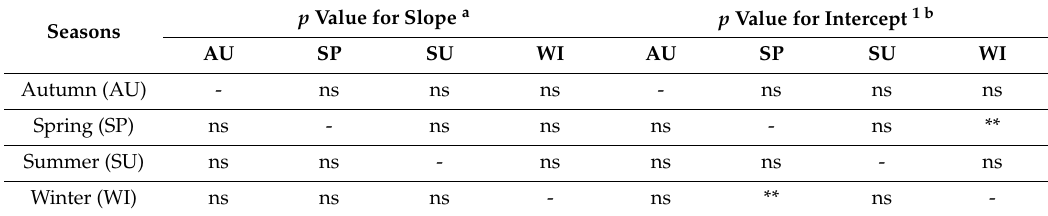
among slopes were assessed by comparing 95% CI. When the slopes were not significantly di ff